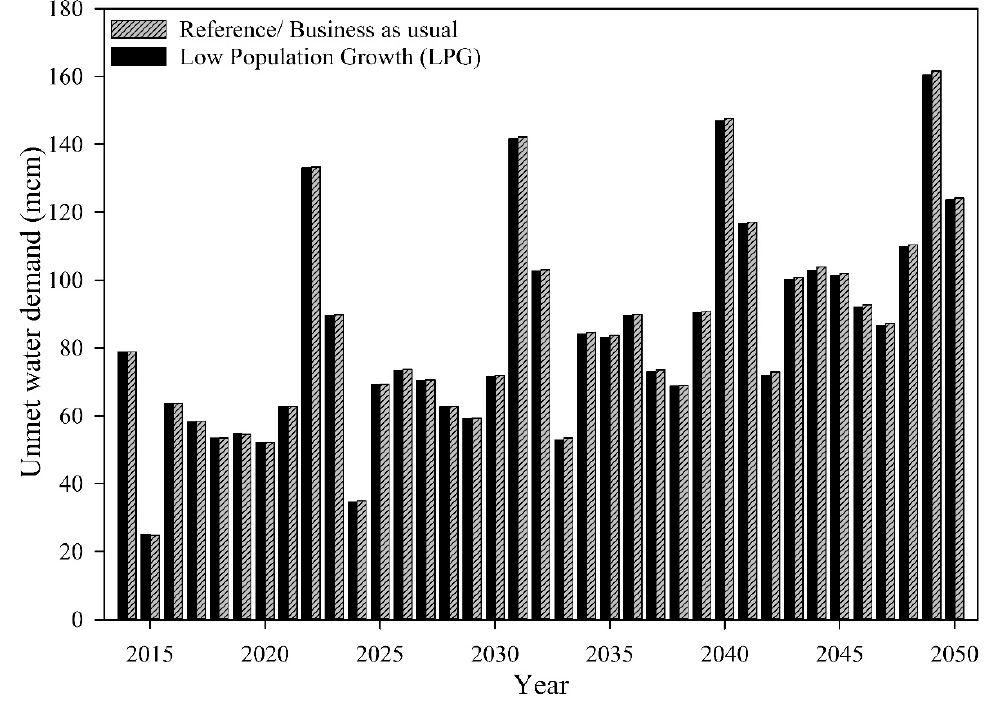
Figure 12. The future projections of the unmet water demands in the Upper Indus Basin (UIB) under the reference and low population growth scenarios.